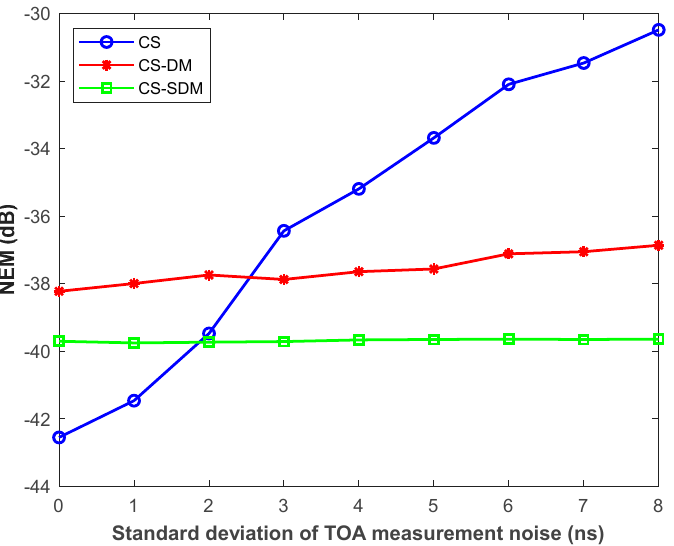
Figure 14. Localization NEM versus standard deviation of TOA measurement noise (SD1) for the three localization systems. T max = 3. Results are averaged over 100 realizations.